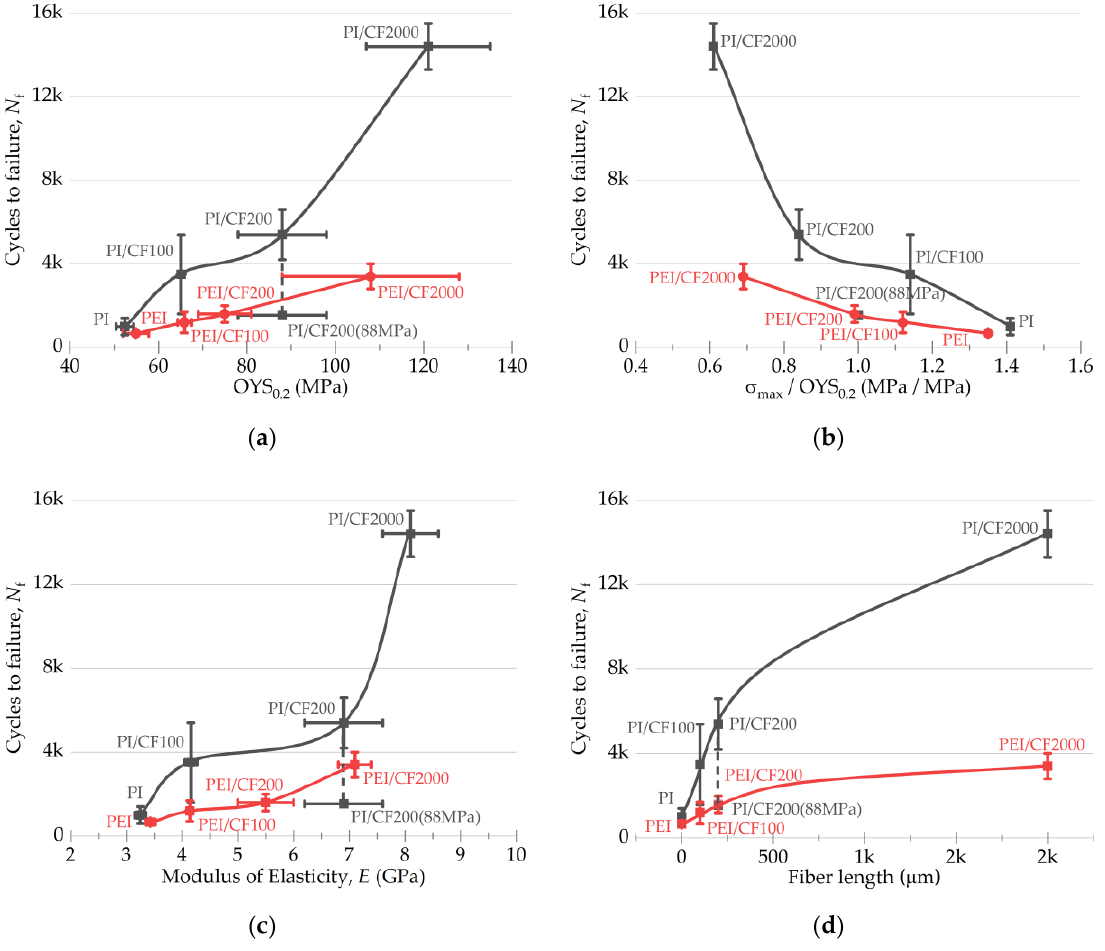
Figure 12. The dependences of a number of cycles to a failure on the elastic and plastic characteristics of the PI- and PEI-based composites ( a , b , c ), as well as the lengths of SCFs ( d ).